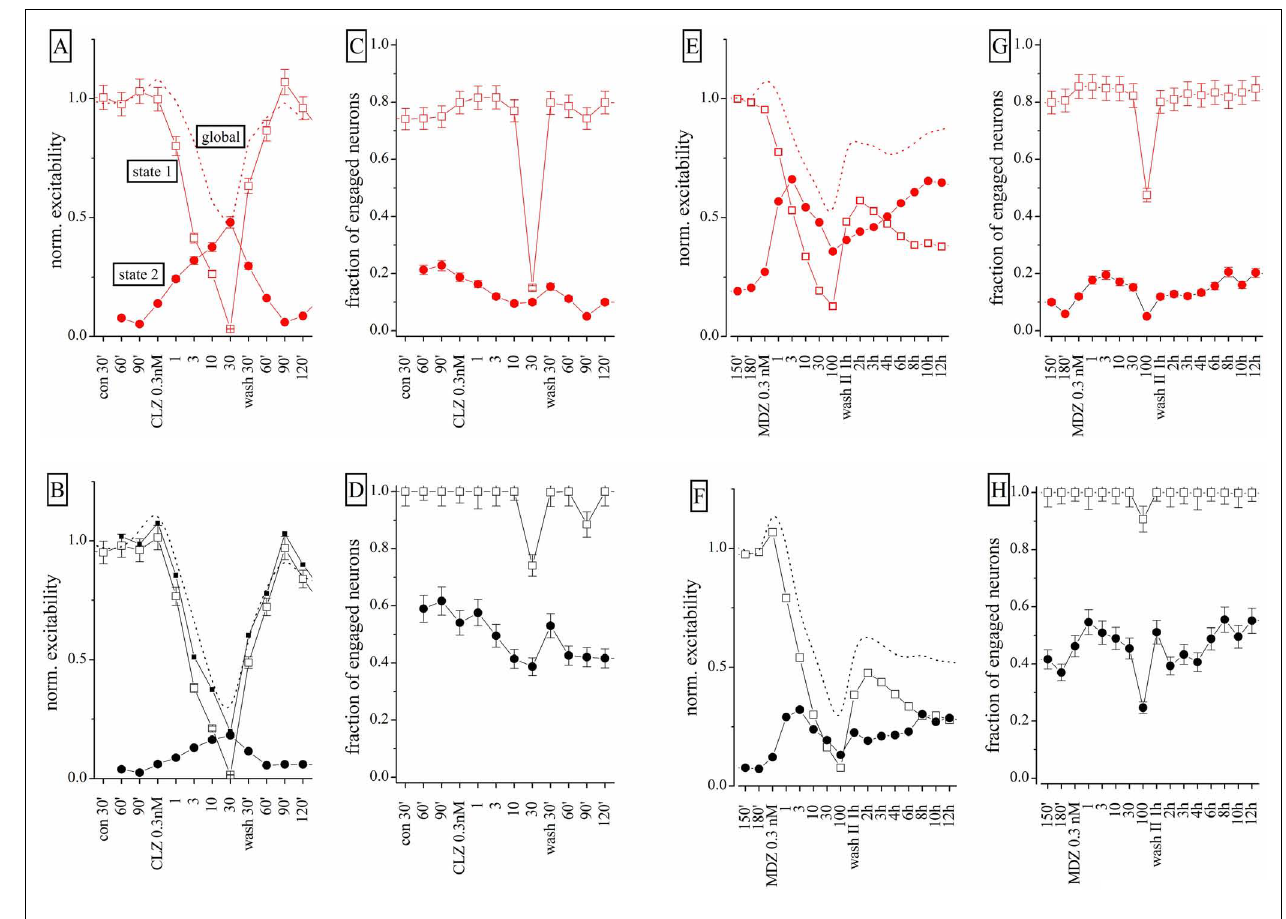
neuron cluster data are shown. Open square and closed circle symbols are related to state 1 and 2, respectively. (A,B,E,F) Plots are related to excitability and (C,D,G,H) plots are related to fraction of engaged neurons. Dotted lines are related to results obtained under the “global” analysis and not under the “state” mode